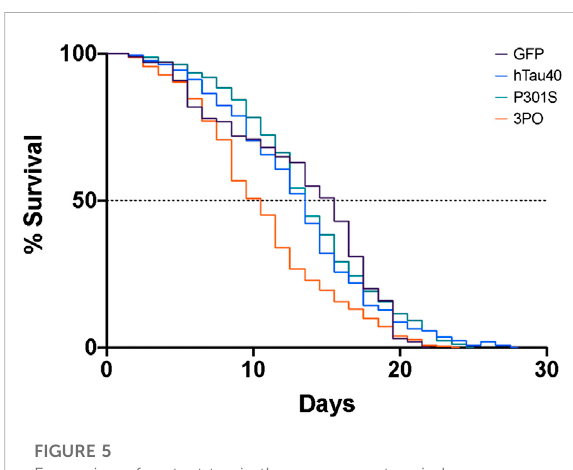
FIGURE 5 Expression of mutant tau in the nervous system induces premature lethality. A cohort of animals expressing GFP, hTau40GFP,P301SGFPor3POGFPwerecounteddailyforsurvival. We determined the day of 50% population survival (LD50). 3PO animals exhibit an LD50 of ~8 days, P301S ~11 days and WT tau of ~12 days (3PO is signi fi cantly different from GFP, p < 0.001, log-Rank test). Each line represents 2 – 5 independent